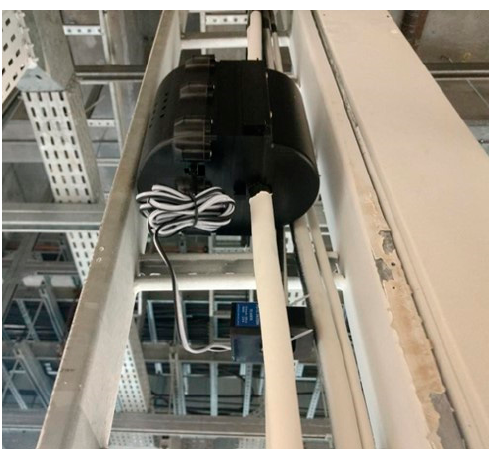
Figure 12. SSWCT with its second measurement current transformer installed at Pimental power plant in the north region of Brazil.